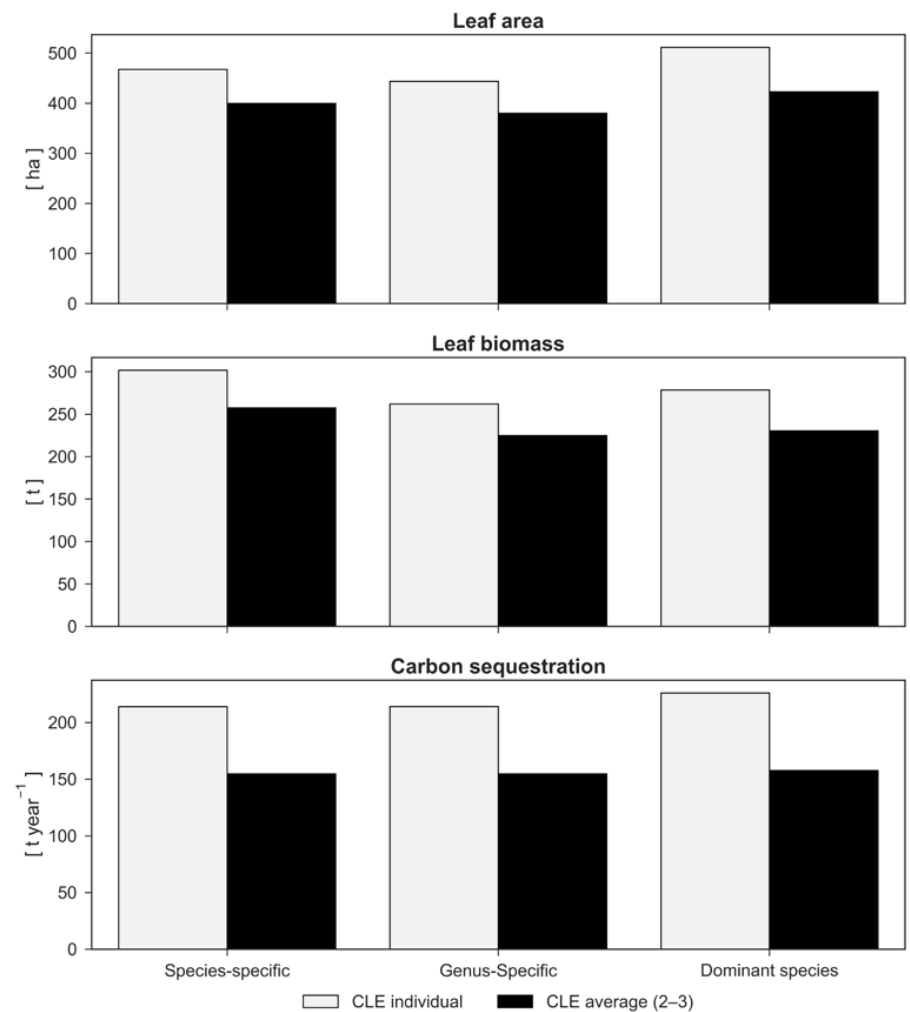
Figure 3. Leaf area (LA), leaf biomass, and carbon sequestration comparison between the “species-specific”, “genus-specific”, and “dominant species” simulations considering the crown light exposure (CLE) value for each tree (CLE individual) and the average CLE values (CLE average).